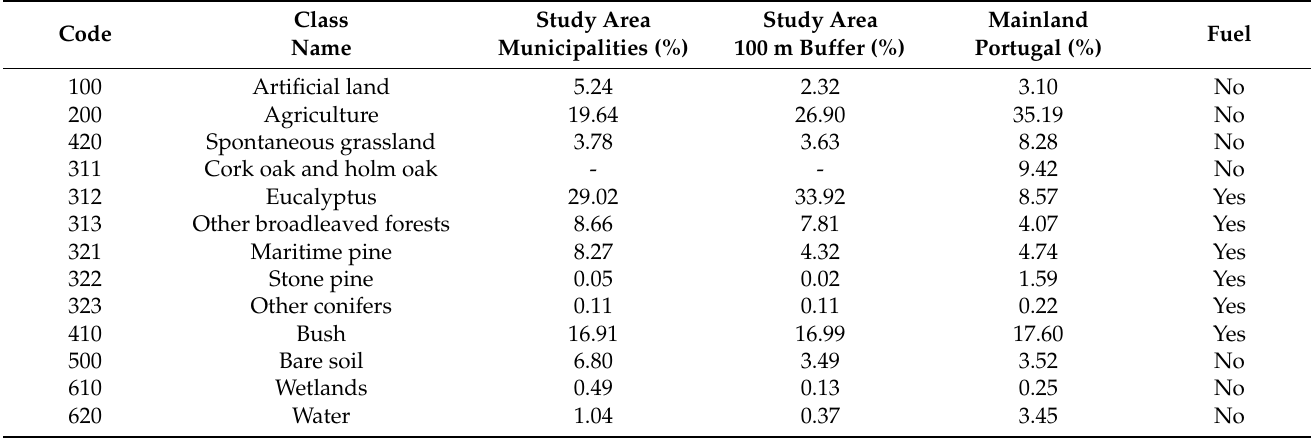
Table 1. COSsim 2018 land cover